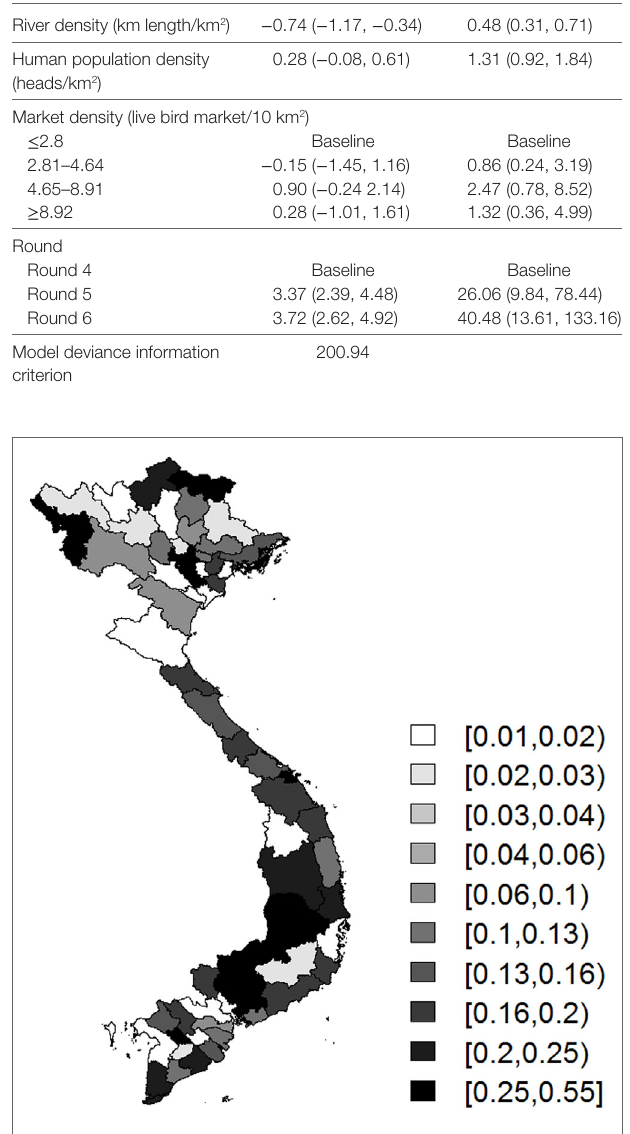
FigUre 7 | Choropleth map showing the province-level posterior mean probabilities of the spatially structured random effect for